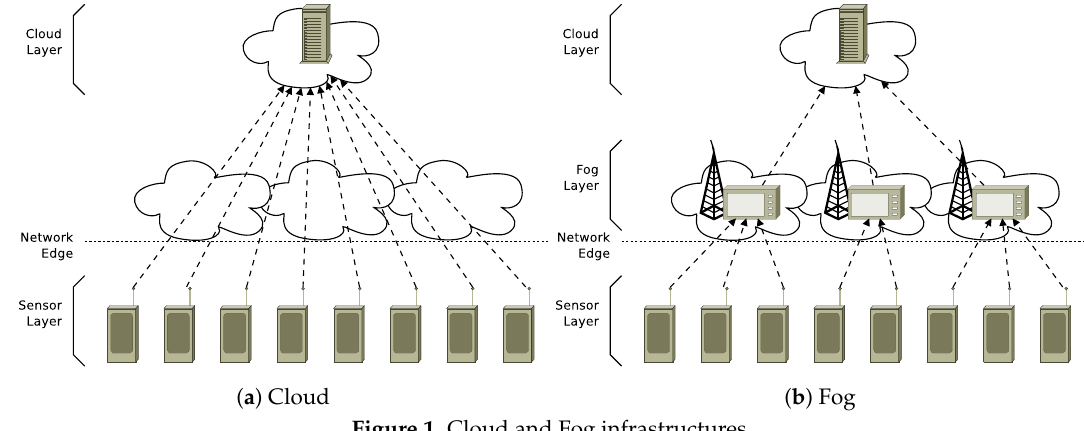
Figure 1. Cloud and Fog